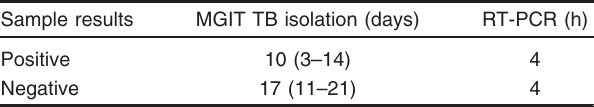
Table 3 Comparison between real-time polymerase chain reaction and Mycobacterium growth indicator tube SIRE drug susceptibility